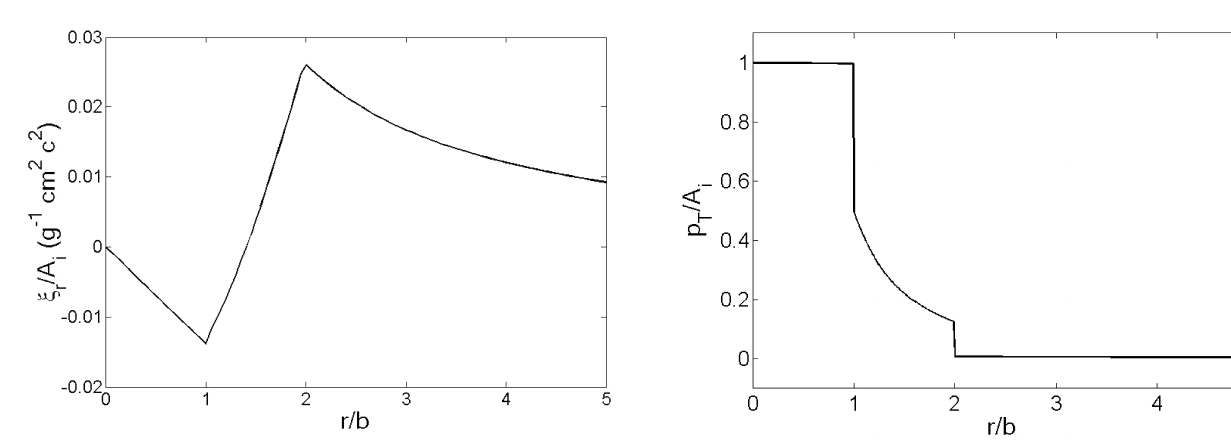
Figure 4. The radial distribution of the total pressure perturbation for the principal sausage mode.